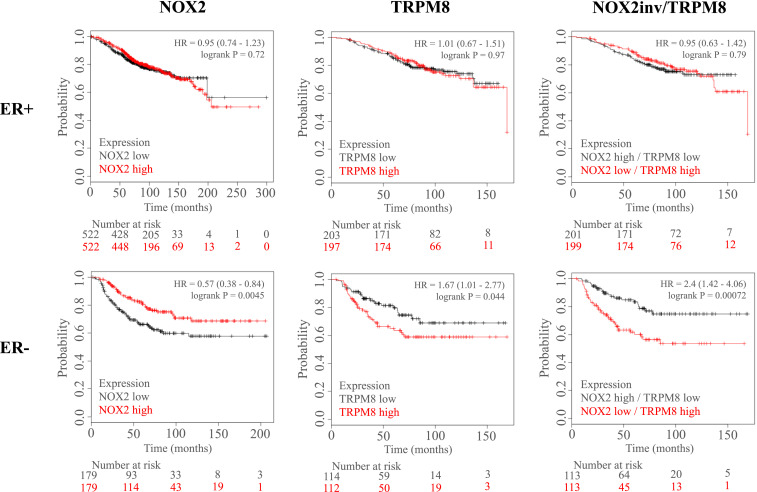
NOX2 and TRPM8 mRNA expression effect estrogen receptor negative patient median overall survival. The Kaplan–Meier Plotter database (KMplotter) was used to test whether components of the mechanically sensitive pathway identified in normal breast MCF10A epithelial cells had an effect on breast cancer patient clinical outcome. Overall survival probability was plotted against time (months) for patients with high vs. low mRNA expression of NOX2 (Left) or TRPM8 (Middle) and were also separated by estrogen receptor-positive (ER+) (Top) vs. estrogen receptor-negative (ER−) (Bottom) status. NOX2 and TRPM8 expression showed no difference in overall survival of ER+ breast cancer patients. Conversely, in ER− patients, NOX2 and TRPM8 showed an inverse outcome on overall survival whereby patients with high expression of NOX2 showed greater survival (hazard ratio, 0.57) and patients with high expression of TRPM8 showed poor survival (hazard ratio, 1.67). Therefore, the combination of NOX2 and TRPM8 mRNA expression was tested for effects on overall survival, but data were separated using inverted NOX2 expression data and unchanged TRPM8 data. The data show that the combination of low NOX2 mRNA and high TRPM8 mRNA was present in ER− patients with poor clinical outcome (hazard ratio, 2.4) vs. patients with NOX2 high/TRPM8 low. The Affy id/Gene symbol used for NOX2 and TRPM8 are (203923_s_at) and (243483_at), respectively. Patient data were split by the median expression level for each gene. Number at risk refers to the number of patients included in each time point.